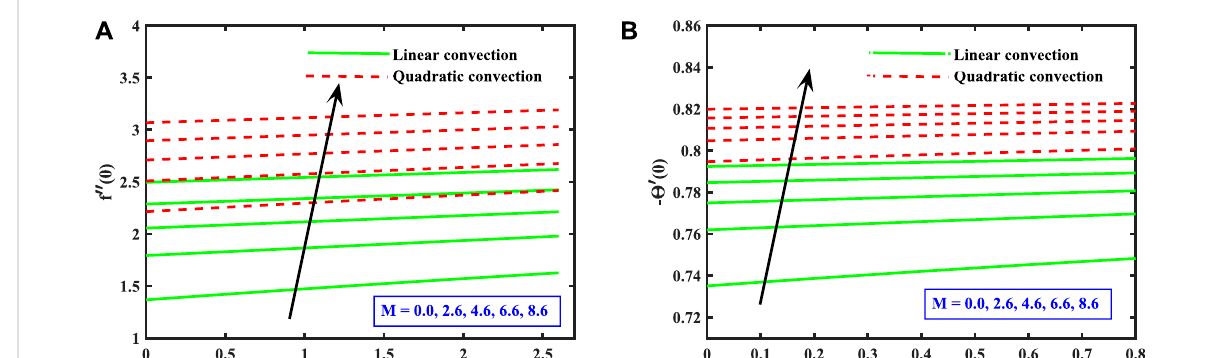
FIGURE 9 The f ′′ (0) and − Θ ′ (0) curves against M and β .